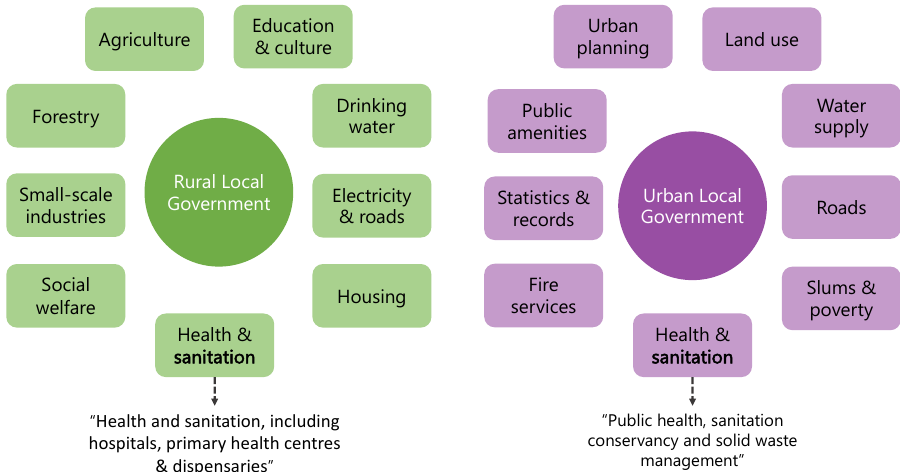
Figure 5. Indicative list of responsibilities of rural and urban local governments as per Schedule XI and XII of the Indian